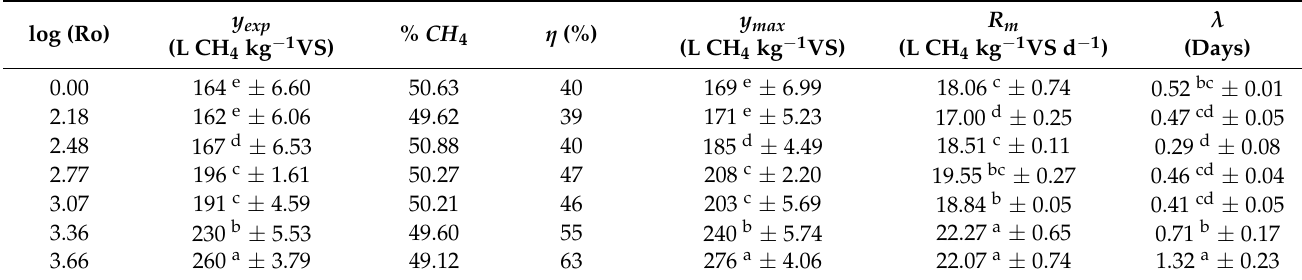
a–e Groups with different superscripts differ ( p < 0.05). Data expressed as mean ± standard deviation. y exp : Experimental yield, % CH Methane content in the biogas, η : overall efficiency of the anaerobic process, y max : ultimate methane yield, R m : maximum methane production rate, λ : lag